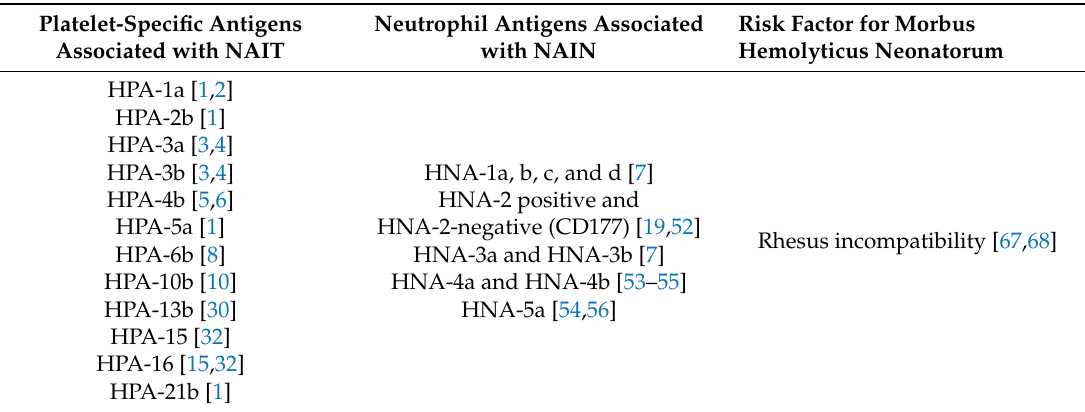
Table 2. Summary of the major